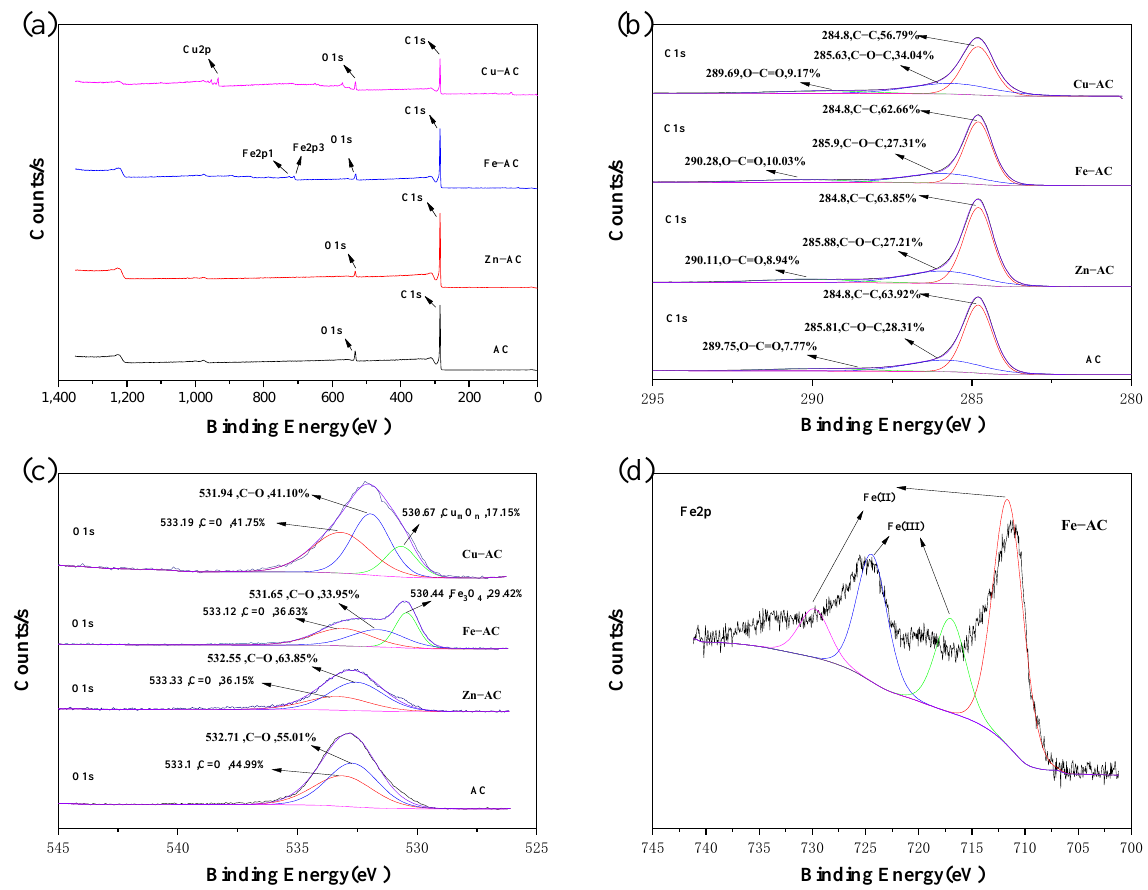
Figure 5. The XPS spectra of the samples: ( a ) XPS total survey spectra; ( b ) C1s; ( c ) O1s; ( d ) Fe2p in Fe − AC.